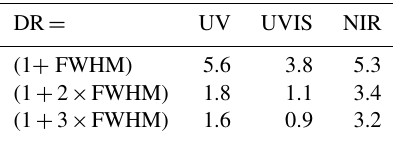
Table 7. Integrated straylight for the UVN detectors calculated from the measurements with the EWLS via the Earth port. Shown are data for three different sizes of the direct region (DR). Straylight is expressed as a percentage of the direct